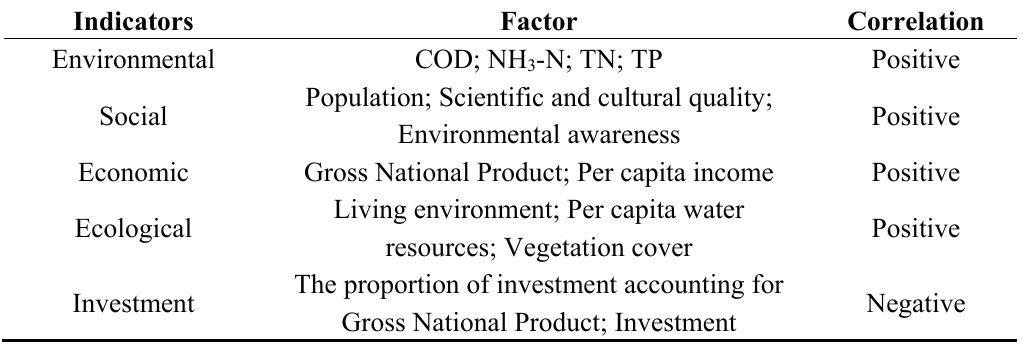
Table 9. The evaluation indicator system of pollution load reduction scenarios.